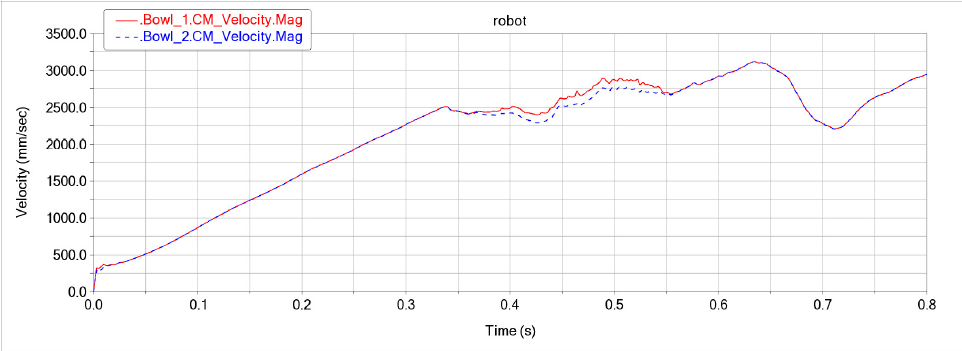
Figure 12. Variation of the robot’s velocity with time in crossing the